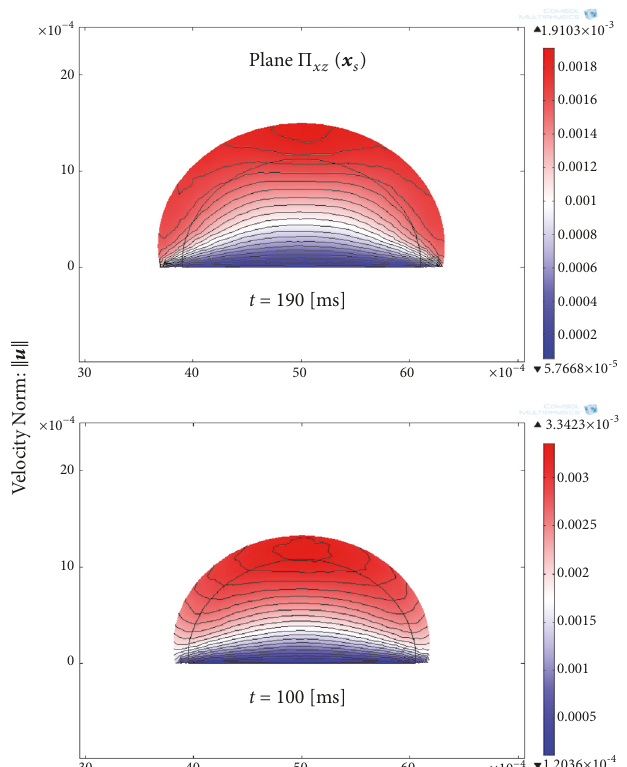
Figure 12: Two-dimensional plots of the velocity norm ‖ u ‖ of two interacting droplets of the same radius 𝑅 1 = 𝑅 2 on the plane Π 𝑥𝑧 ( x 𝑠 ) at times 𝑡 = 100 , 190 [ms]. The solid lines stand for the iso- ‖ u ‖